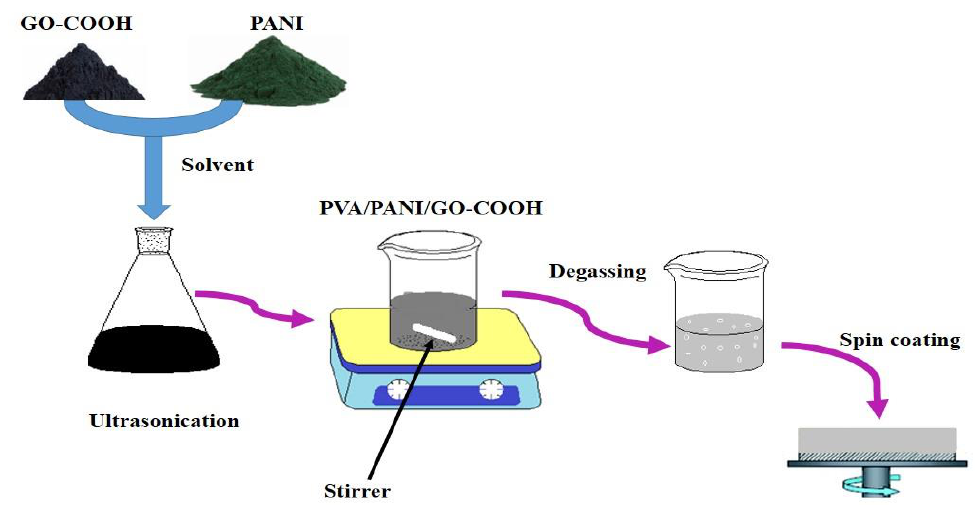
Figure 1. Schematic illustration of preparation process of the PVA/PANI blended GO-COOH nanocomposite coatings.